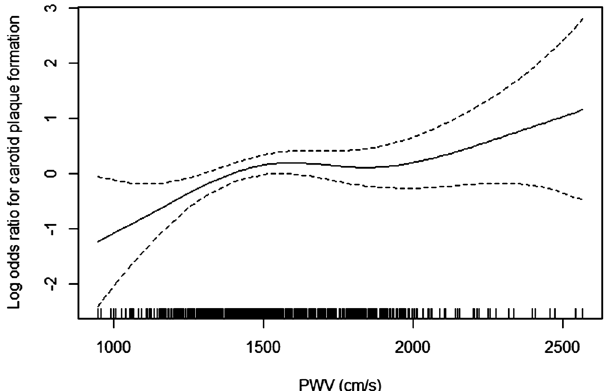
Figure 2. Smooth curve of the trend of the relationship between carotid plaque formation and the ba-PWV.